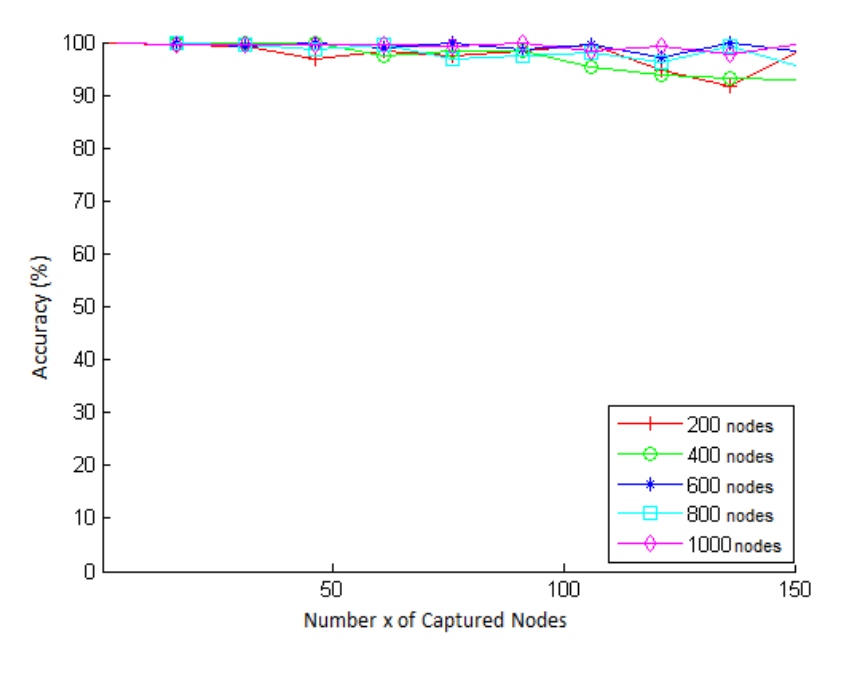
) vs. the number x of R